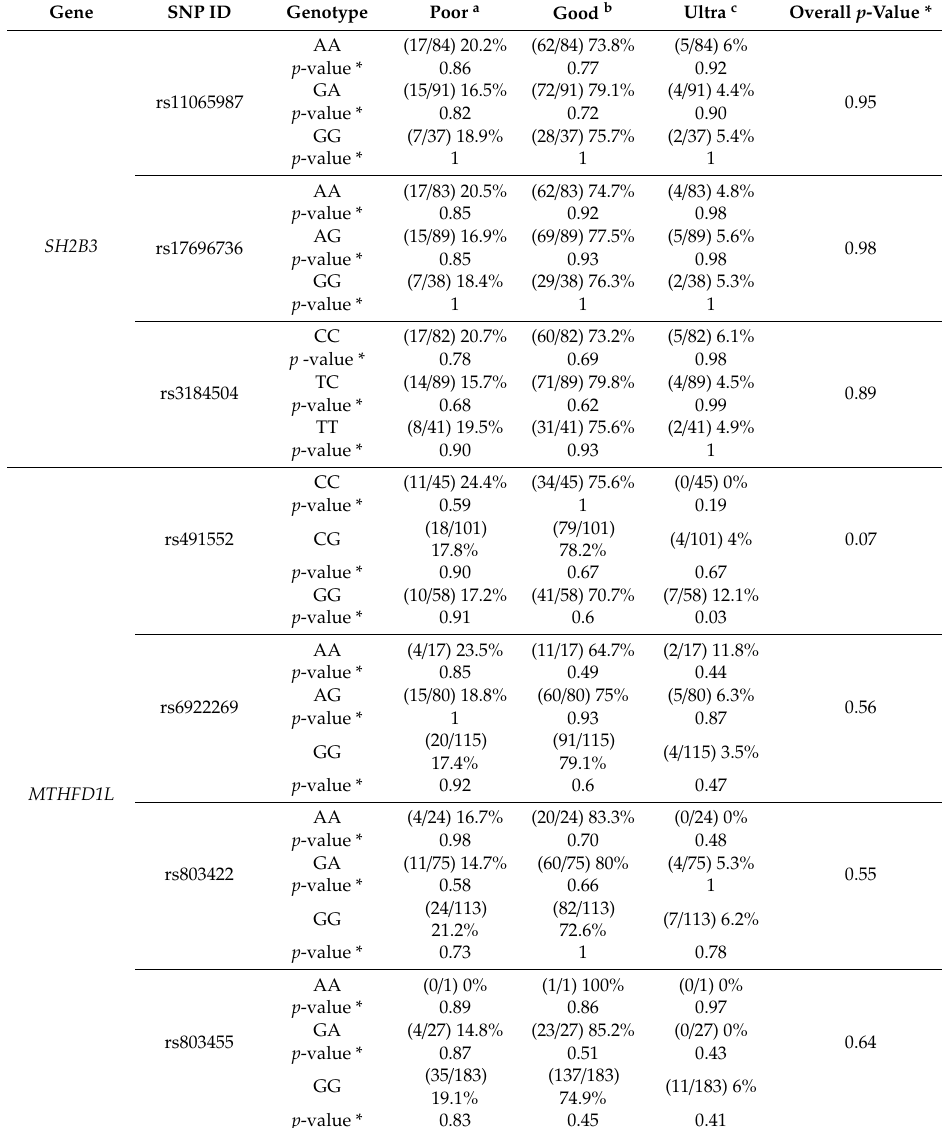
Table 5. Association of SH2B3 and MTHFD1L SNPs with warfarin responsiveness during the initiation phase of therapy of 212 cardiovascular patients treated with